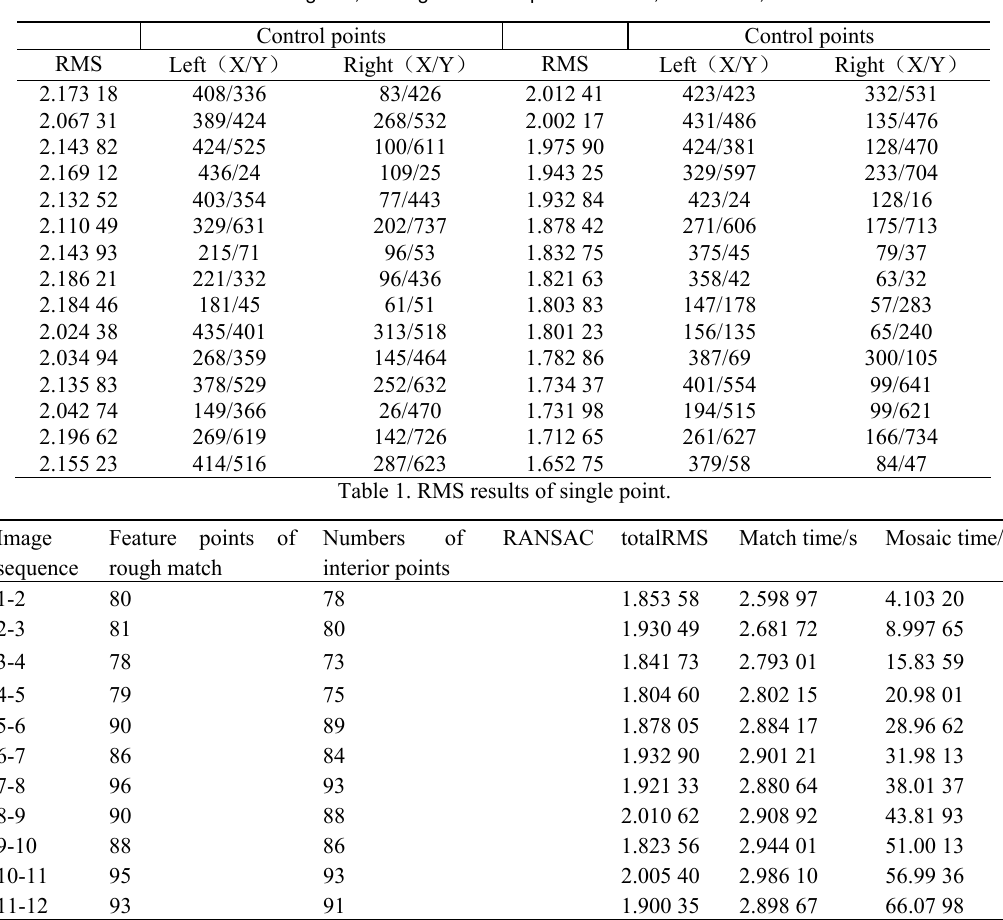
Table 2. Index statistics of the experiment